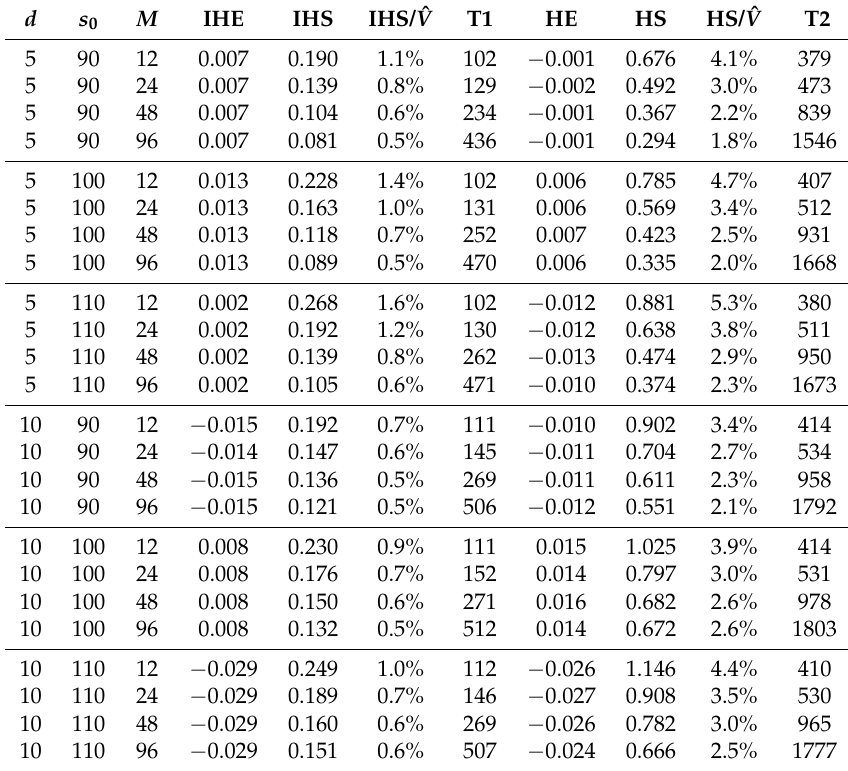
Table 2. Average hedging errors and empirical hedging shortfalls for 5 and 10 underlying assets and different numbers M of rehedging times between consecutive exercise times t n − 1 and t n . The values of the parameters r , δ , σ , ρ , K , T and N were chosen as in Table 1. IHE is the intermediate average hedging error (8), IHS the intermediate hedging shortfall (9), HE the total average hedging error (10) and HS the total hedging shortfall (11). ˆ V is our price estimate from Table 1. T1 is the computation time in seconds for training the hedging strategy from time 0 to t 1 = T / N . T2 is the number of seconds it took to train the complete hedging strategy from time 0 to T